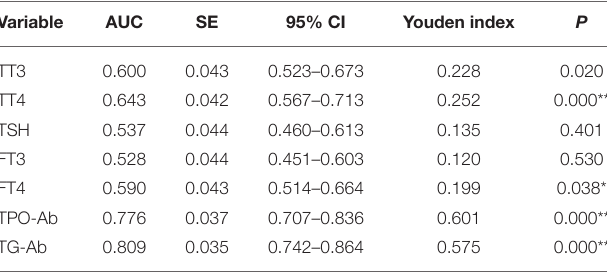
TABLE 3 | Analysis of the ROC curves of thyroid function and autoantibodies parameters in the GBS and CIDP groups. Variable